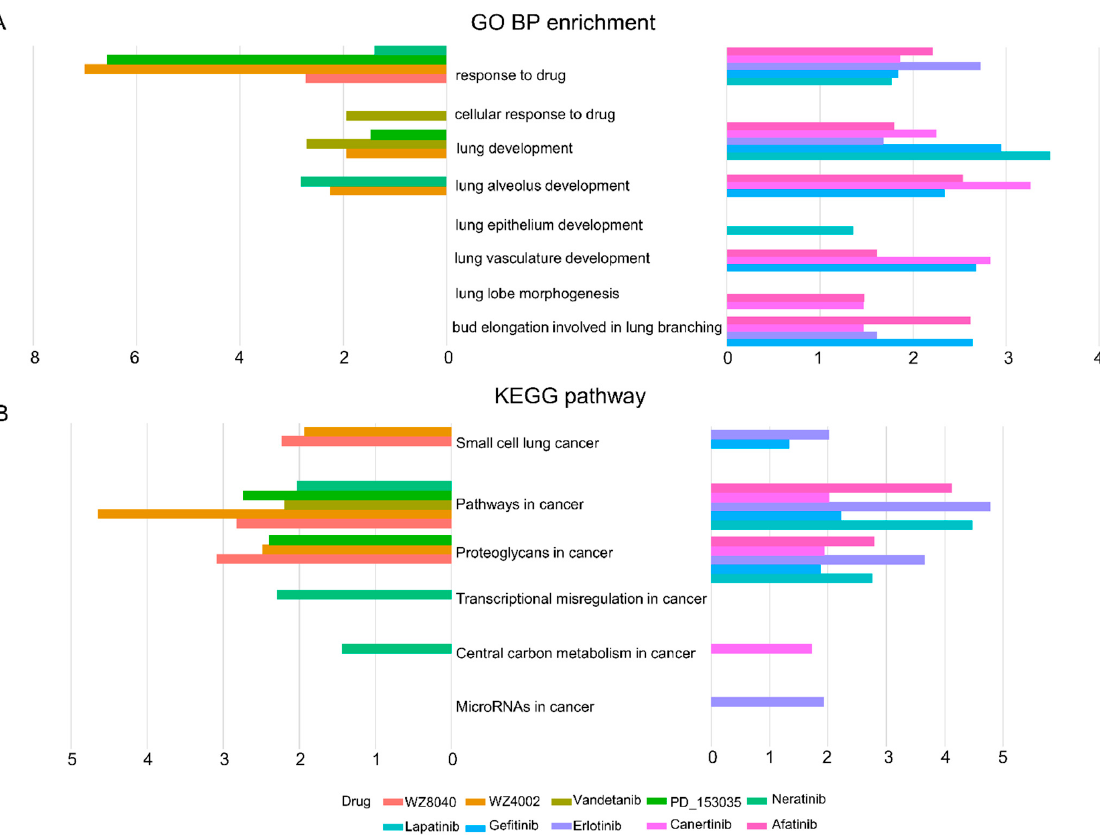
Figure 3. Biological process and pathway enrichment of EGFR inhibitor-responsive genes. ( A ) Introduce the GO database to view the predicted EGFR inhibitor-responsive gene enrichment and view which were related to the biological processes related to drugs and lungs. ( B ) Introduce the KEGG database to check which gene pathways related to cancer were related to the predicted EGFR inhibitor-responsive genes.